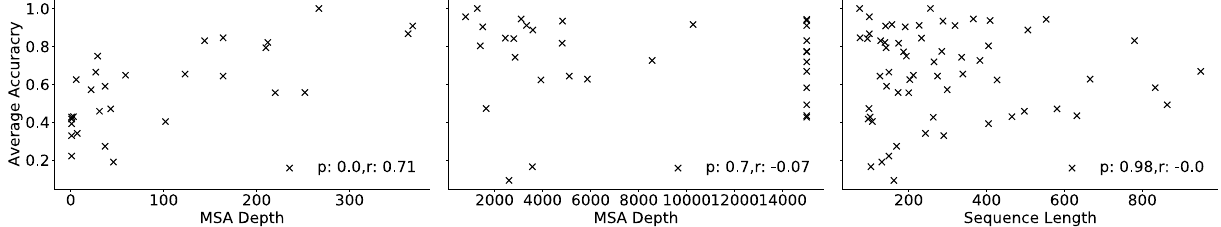
Figure 2. Left: correlation analysis of average accuracy (see text for definition) for CASP14 targets with MSA smaller than 400 sequences. Middle: correlation analysis for MSA deeper than 400 sequences. Right: correlation analysis of average accuracy and target amino acid sequence length.